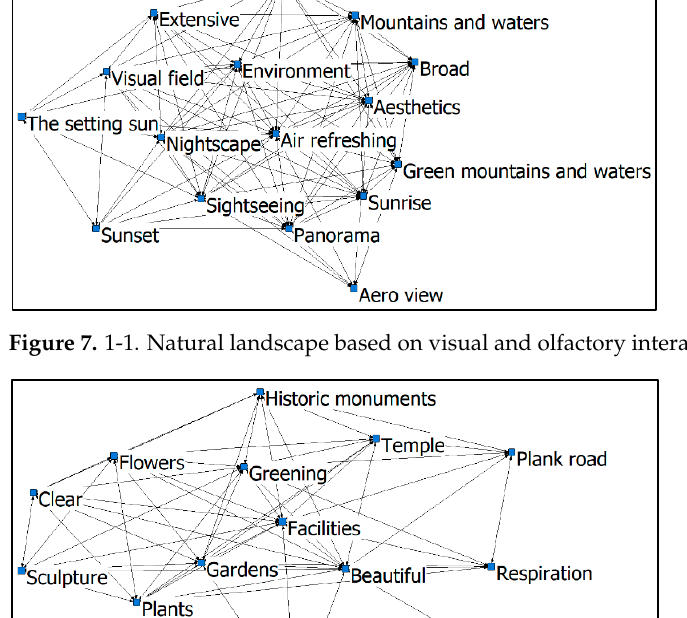
Figure 9. 1-3. Visual and olfactory interactive experience during outdoor activities.